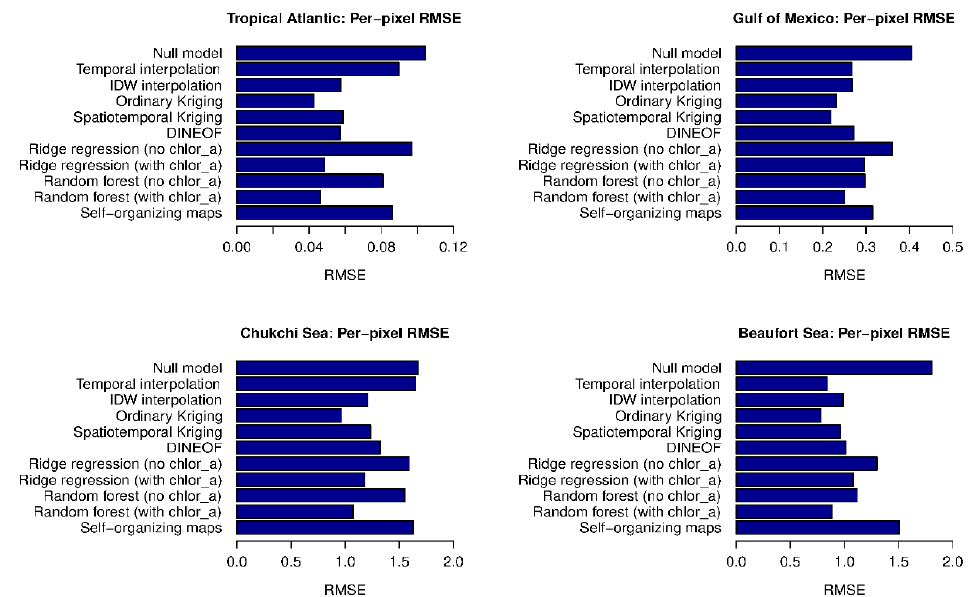
Figure 5. Means of the algorithms’ per-pixel RMSEs in the four study areas ( 𝑅𝑀𝑆𝐸 𝑝𝑝 , Equation (6)). The null model filled all gap pixels with the mean of all pixels that had data. Because of different means and ranges of Chl a concentrations, RMSEs should not be compared across study areas.